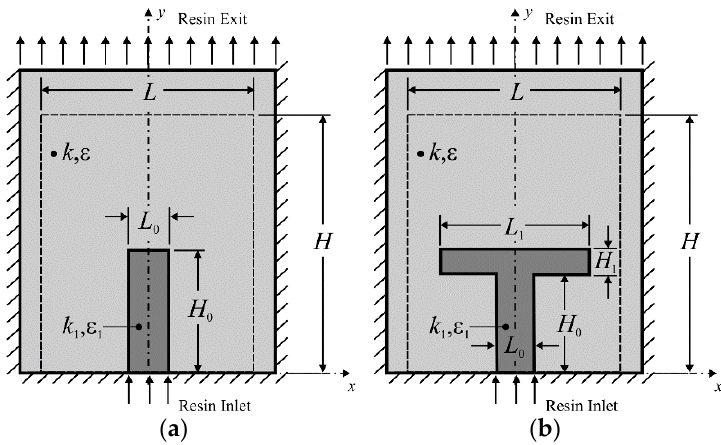
Figure 1. Computational domain of the problem, which mimics the liquid resin infusion (LRI) process with two empty channels geometries: ( a ) I-shaped, ( b ) T-shaped.